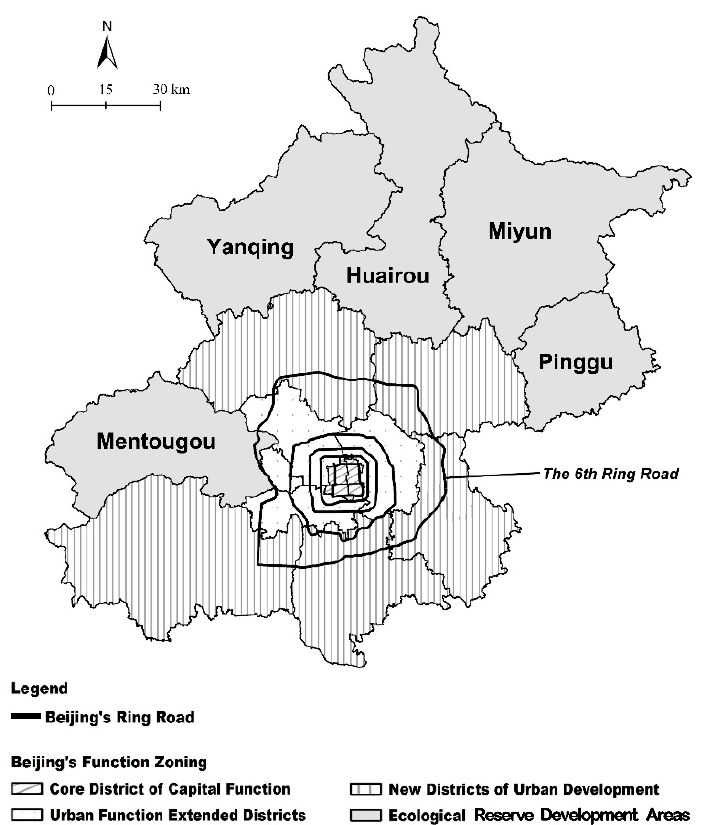
Figure 3. Map for the Beijing Municipality and its main functional zones.